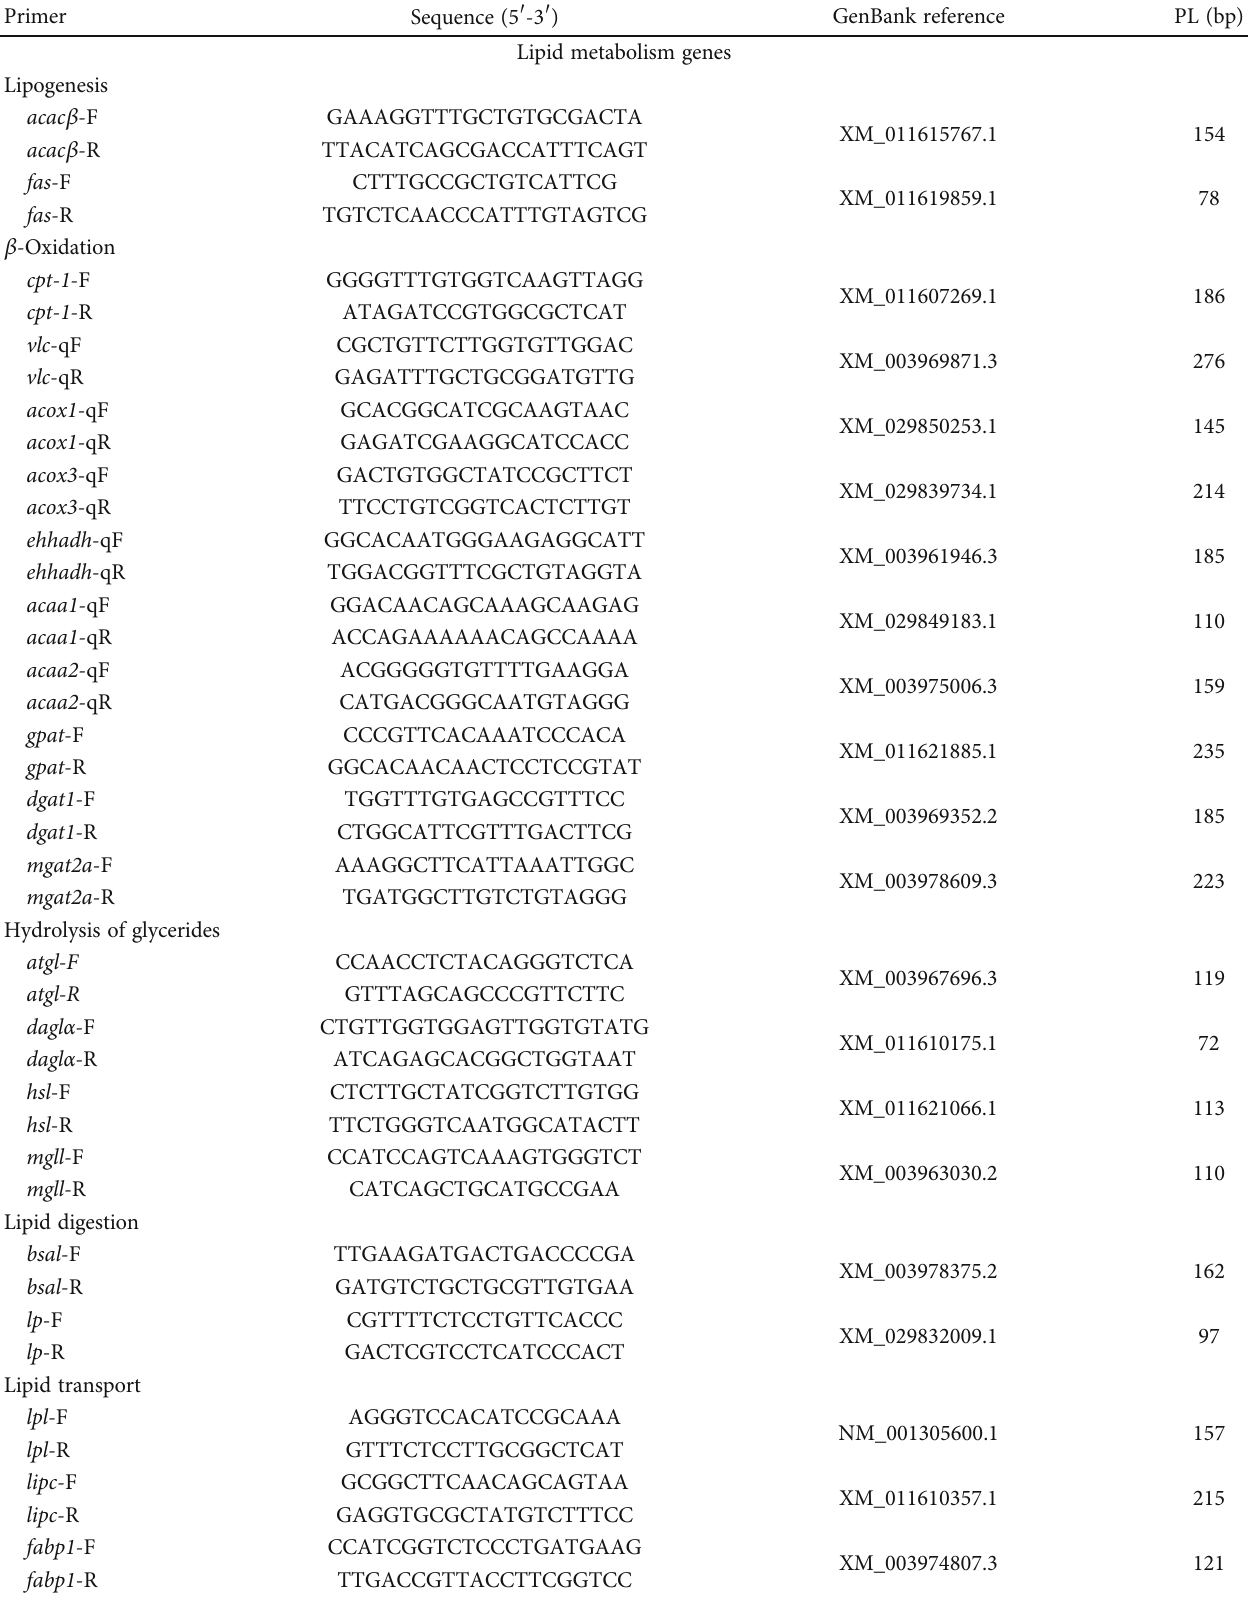
Table 3: Sequence information of the primers used in this